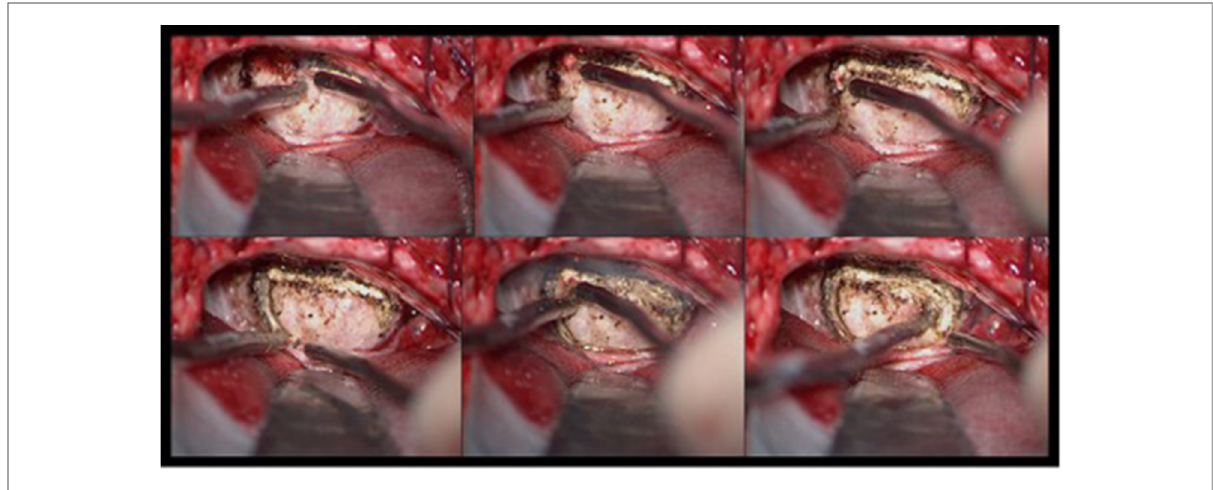
FIGURE 3 Pictures of application of the thulium laser in meningioma surgery. We appreciate in the image (look from top left to bottom right) sequential pictures of tumor capsule